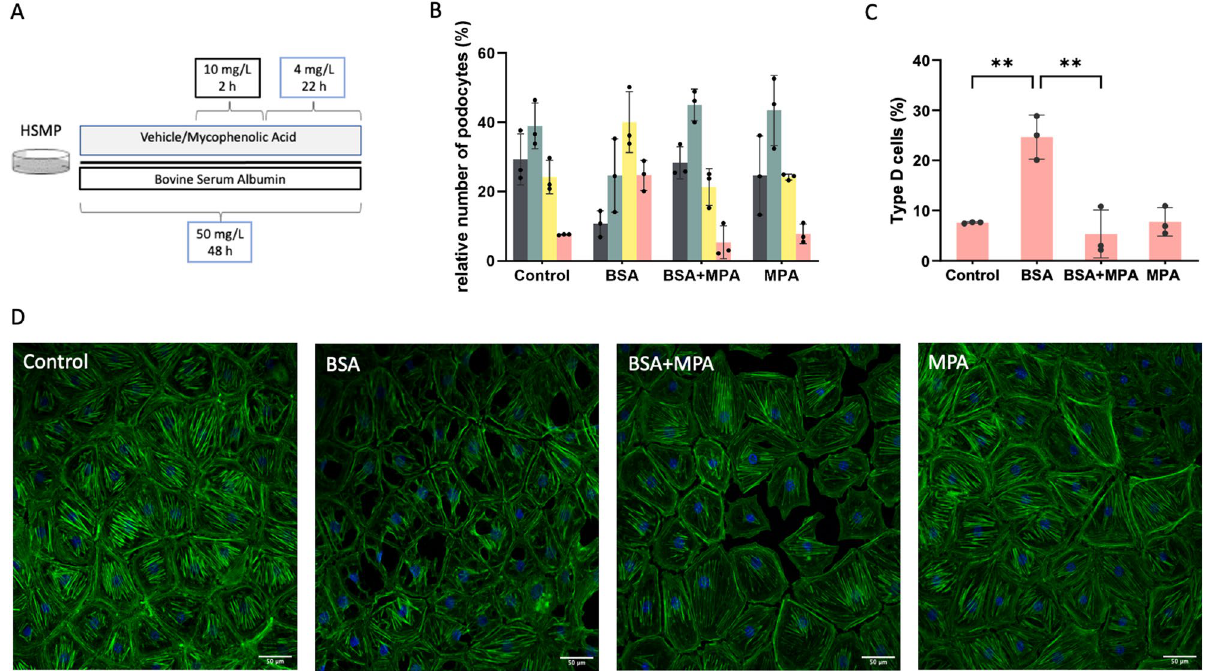
Figure 2. MPA protects the actin cytoskeleton from BSA induced injury. ( A ) Cells were treated with bovine serum albumin (BSA) for 48 h and received either MPA or Vehicle for the second 24 h. The actin cytoskeleton was visualized using immunofluorescence staining. ( B ) Quantification of different cell types after treatment with bovine serum albumin (BSA) and Mycophenolic Acid (MPA). Grey = Type A: > 90% of cell area filled with thick cables; green = type B: at least two thick cables running under the nucleus, with the rest of the cell area filled with fine cables; yellow = type C: no thick cables but some cables present; red = type D: no cables visible in the central area of the cell. BSA treatment decreases healthy Type A and B cells, while increasing less healthy Type C and D cells. Additional MPA treatment reverses this effect in all categories, increasing Type A and B cells compared to BSA only, while decreasing Type C and D cells. The treatment with only MPA resulted in a similar distribution of cell types as in controls. At least 90 cells were analyzed per sample. ( C ) Quantification of Type D cells for each treatment. Treatment with BSA significantly increases the number of cableless D cells. In contrast additional treatment with MPA significantly decreases the number of D cells compared to treatment with only BSA ** p < 0.01. ( D ) Representative confocal images of the podocytes after each respective treatment. Green, phalloidin. Blue,